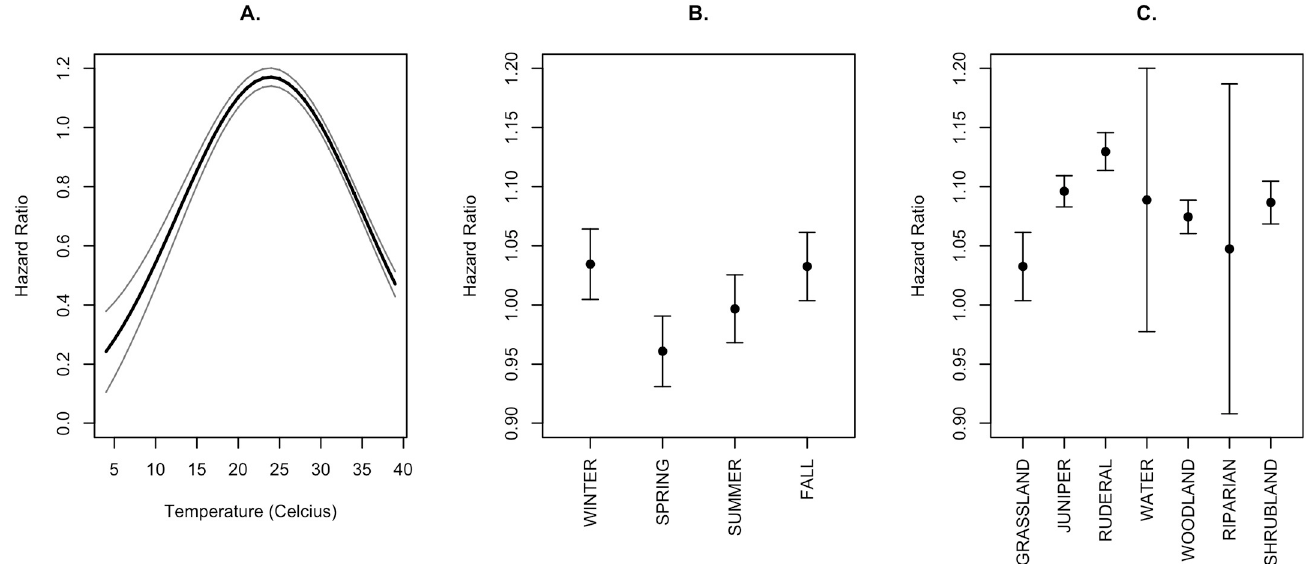
Fig 3. Predicted effects on hazard ratios using our top cox proportional hazard model on A. Temperature, B. Season, and C. Landcover type. 95% confidence intervals are represented by grey lines (A) or horizontal error bars (B, C).